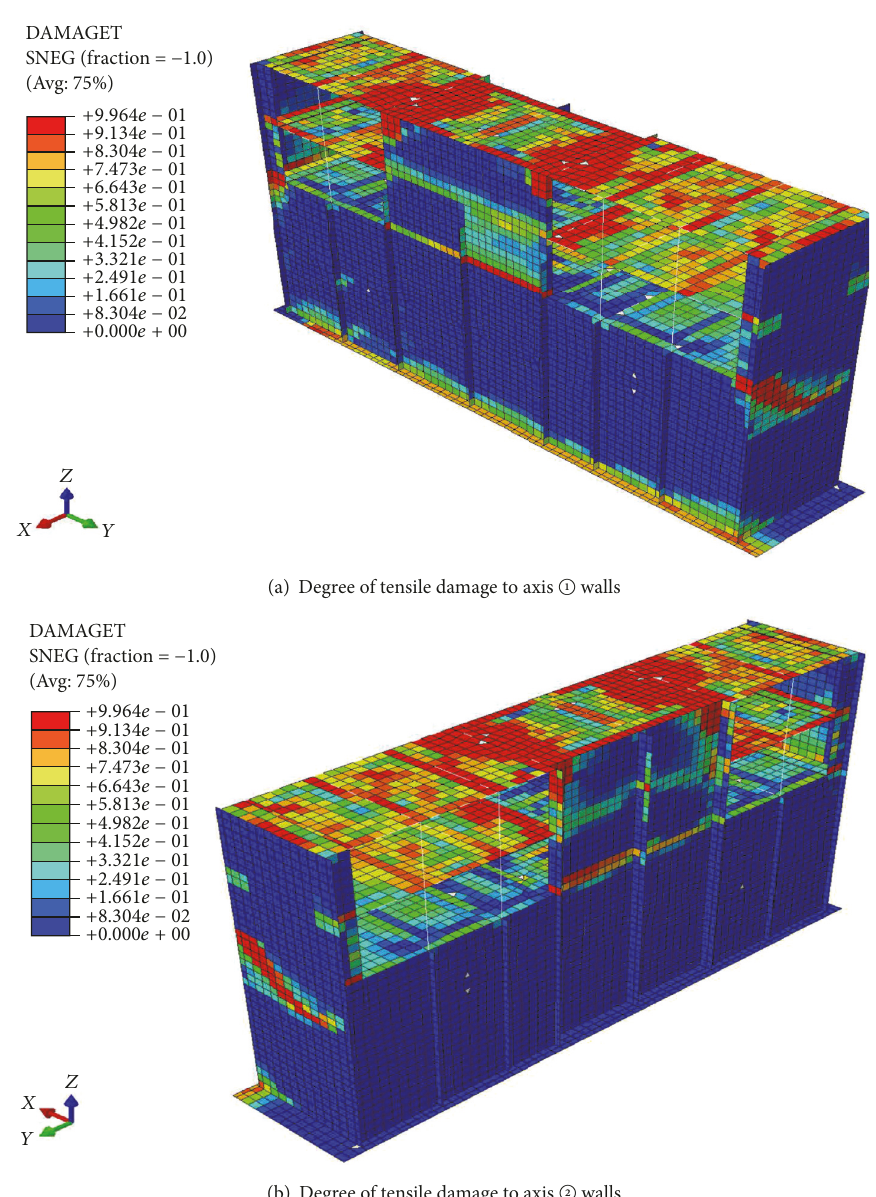
Figure 12: Seismic damage in the FEA